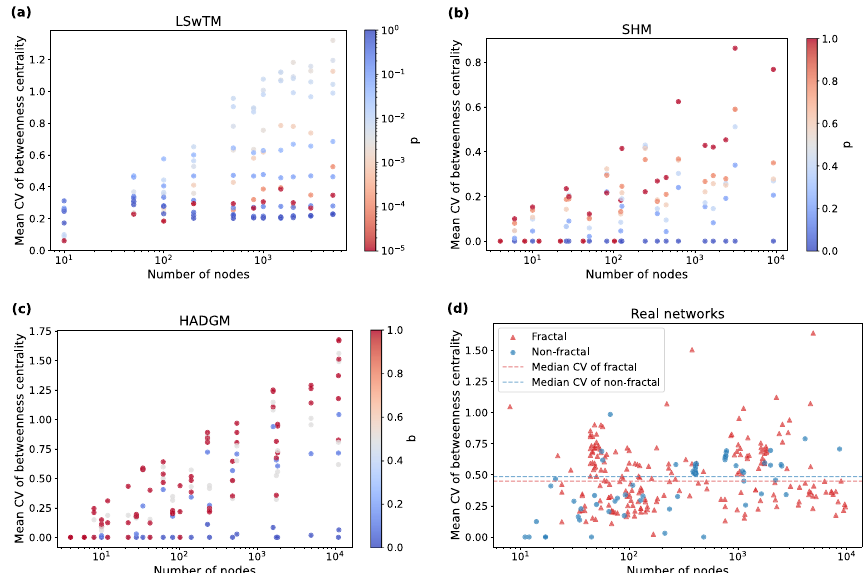
Fig. 23 The mean coefficient of variation (CV) of the betweenness centrality per degree. The fractal networks are colored red and the non‑fractal networks are blue. The difference in the distribution of the mean CV of the fractal and non‑fractal real networks is not statistically significant (Mann–Whitney U rank test’s p value: